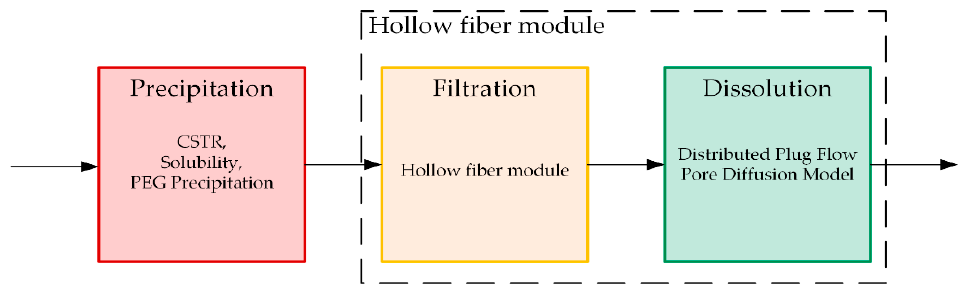
Figure 14. Subareas of the process model for the unit operation precipitation.